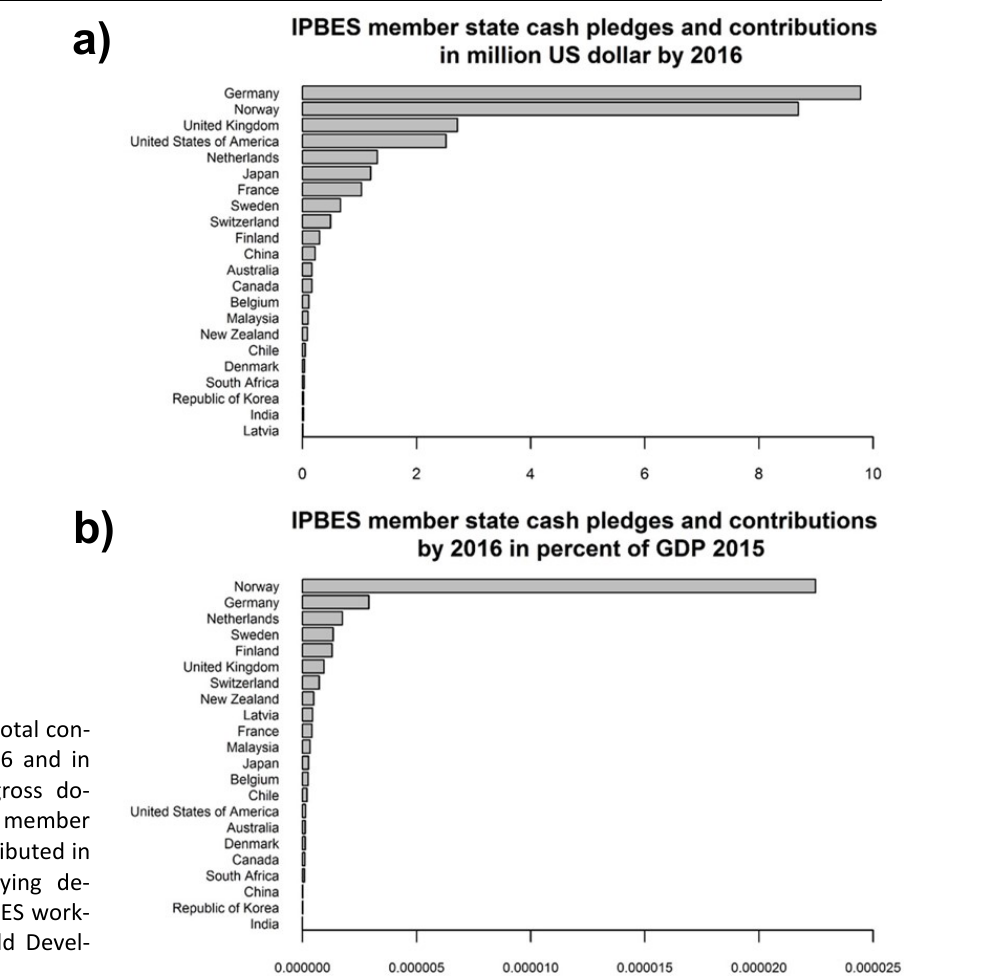
Figure 1. IPBES member state total con- tributions and pledges by 2016 and in relation to their respective gross do- mestic products. Of the 126 member states, 22 countries have contributed in cash, though in strongly varying de- grees. Data are taken from IPBES work- ing document 5-10 and "World Devel- opment Indicators 2